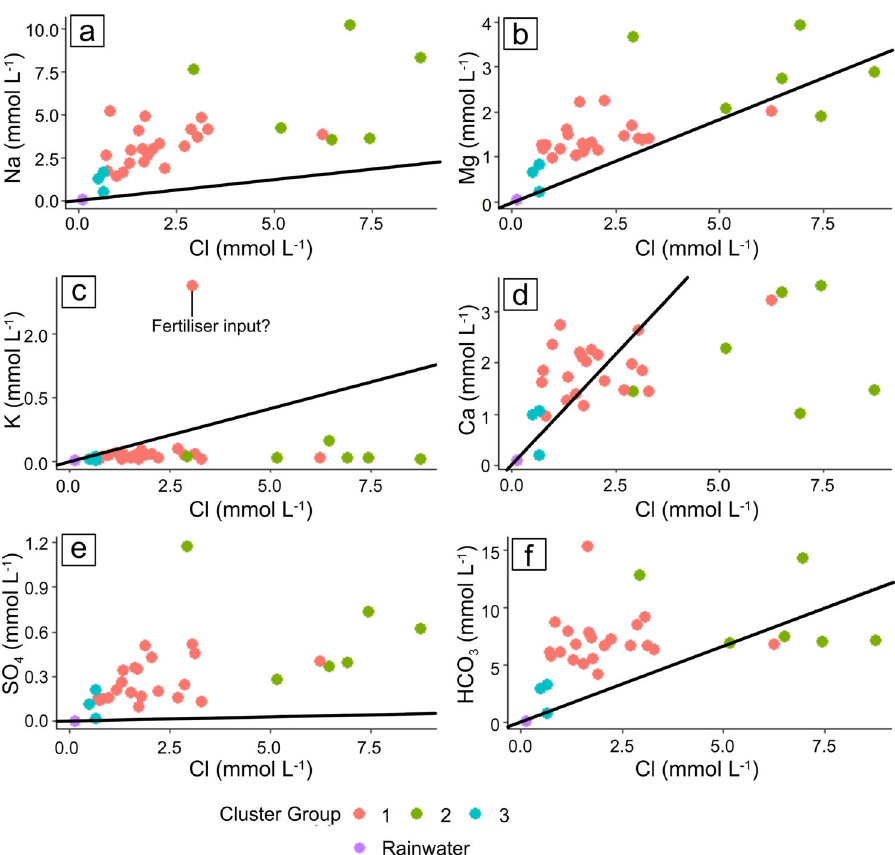
Fig. 2 Bivariate plots. Cl vs a Na, b Mg, c K, d Ca, e SO 4 and f HCO 3 . The black line on each plot indicates the ratio of Cl to each ion present in rainwater from Vavuniya, north of the study site 54 . Points above the line indicate enrichment in the major ion compared to chloride, suggesting that the source of the ion is from mineral weathering rather than rainwater. Points below the line suggest depletion of the ion compared to Cl, indicating removal through an exchange process or mineral precipitation process.